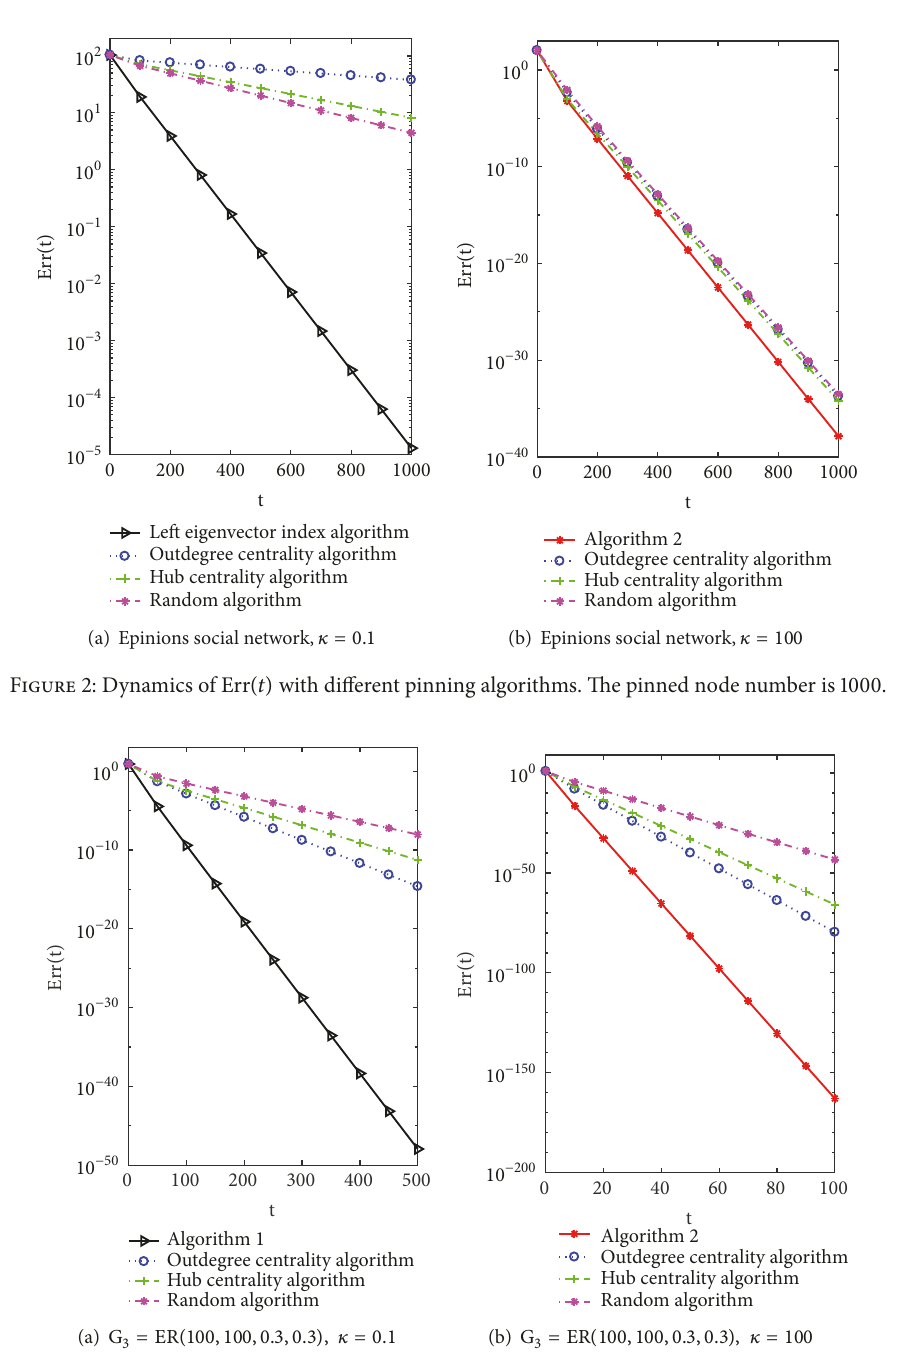
Algorithm 1 Outdegree centrality algorithm